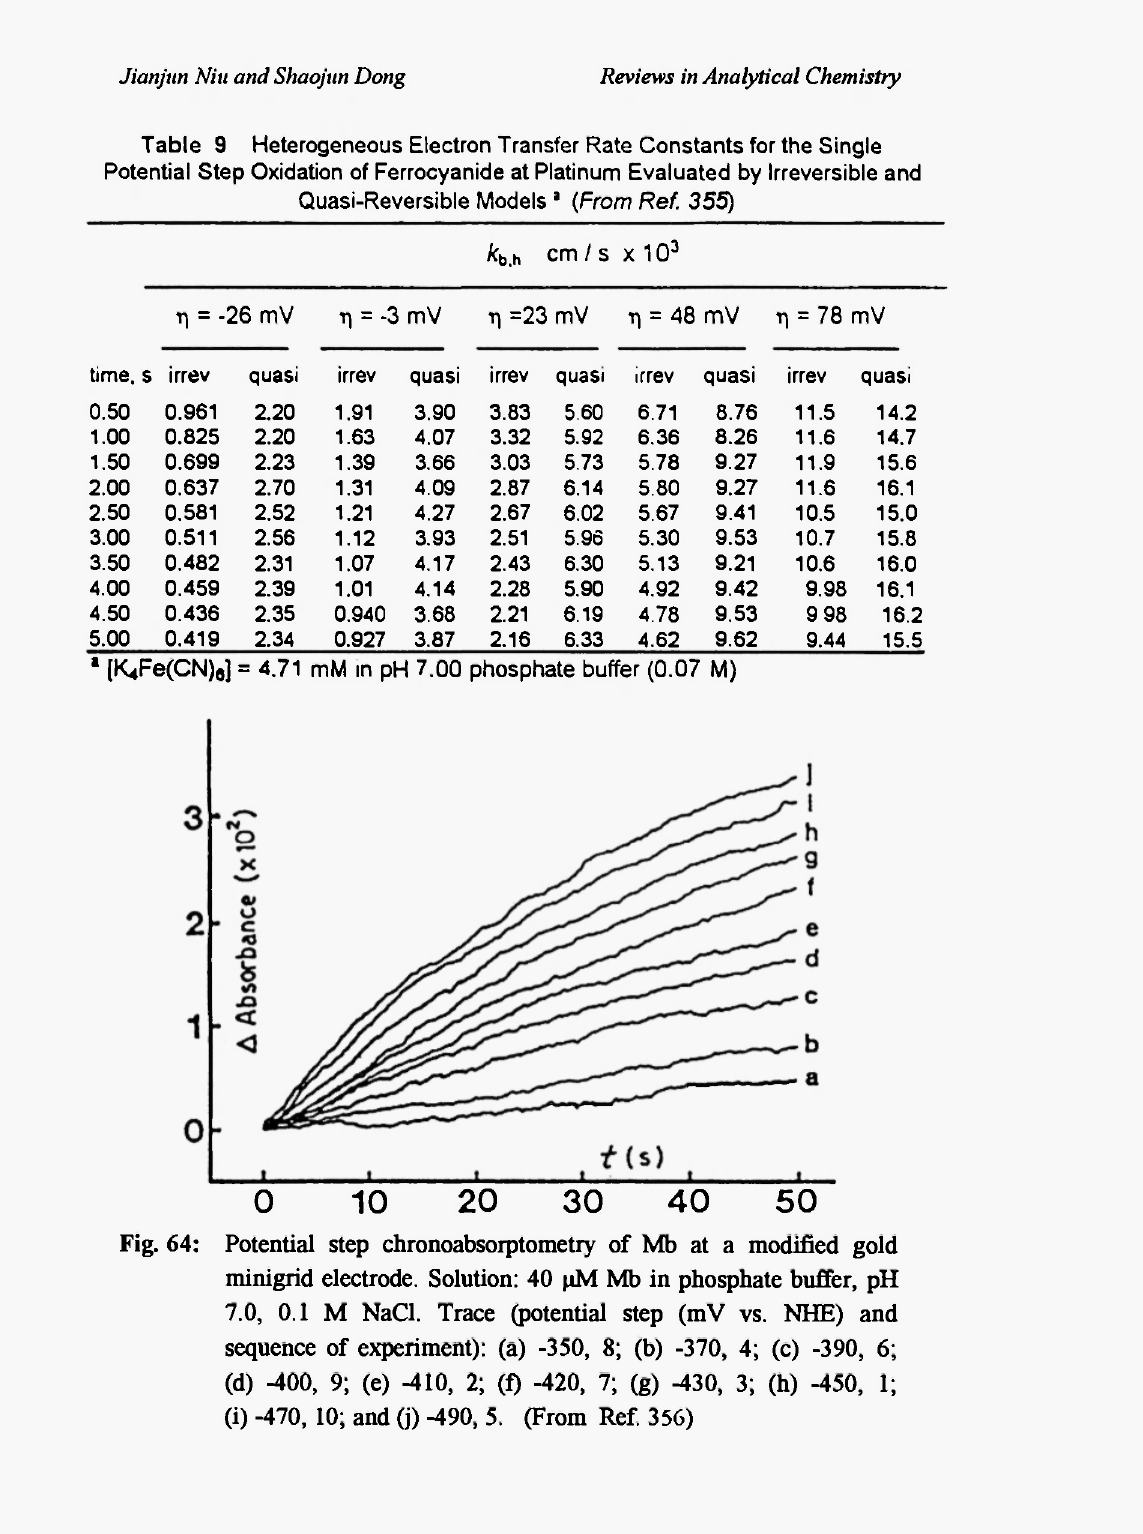
Heterogeneous Electron Transfer Rate Constants for the Single Potential Step Oxidation of Ferrocyanide at Platinum Evaluated by Irreversible and Quasi-Reversible Models a ( From Ref. 355)